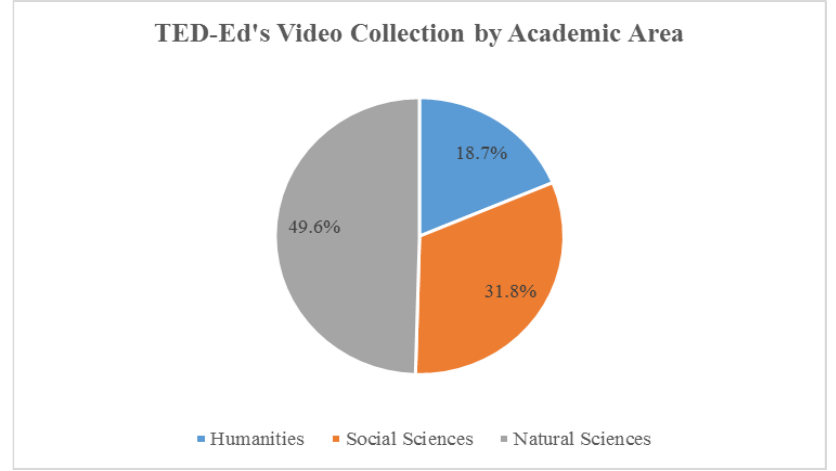
Figure 4. The total video distribution by academic area.